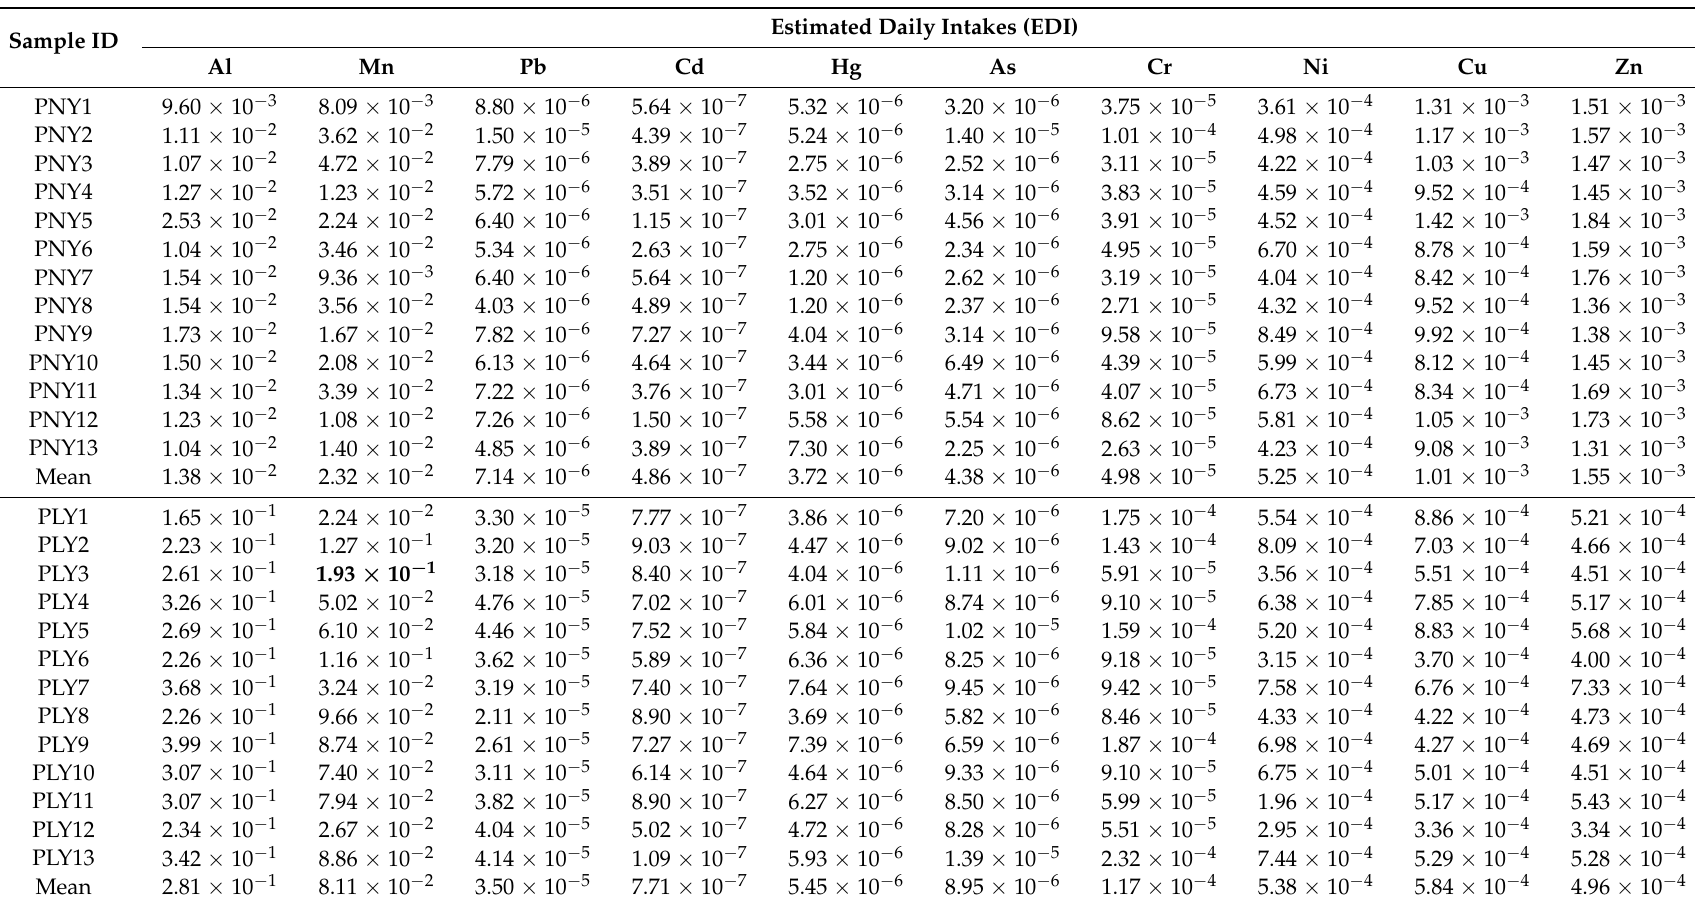
Table 5. Estimated daily intakes (EDI) (mg/kg bw/day) of Al and heavy metals for adults due to the consumption of tea leaves in Puan tea growing area. Sample